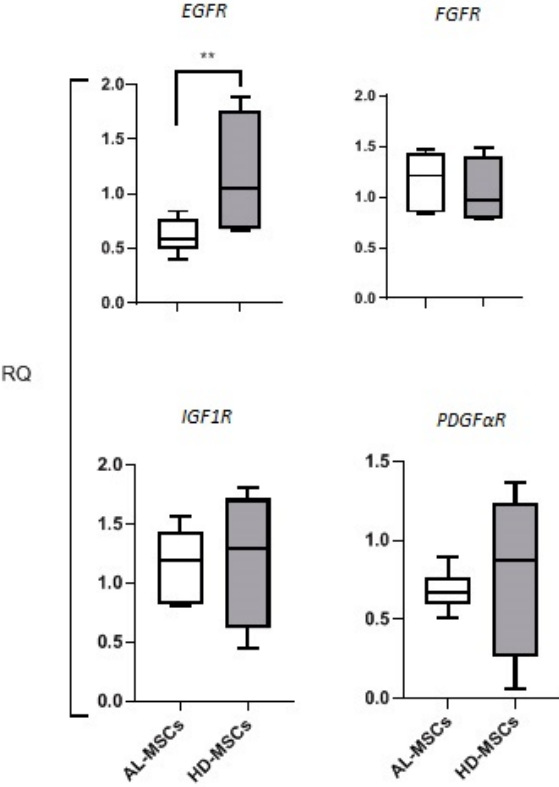
Figure 5. Relative expression pattern of genes encoding for growth factor receptors. The evaluation of transcript levels for genes encoding EGFR, FGFR, IGF1R, and PDG α R was performed in AL- and HD-MSCs by semiquantitative RT-PCR. The expression level for each gene was calculated using the RQ method, normalizing the expression of the gene of interest with the expression of a reference gene (GAPDH) in the same sample. Results are shown as median [25–75%, Min-Max]. ** p = 0.036.